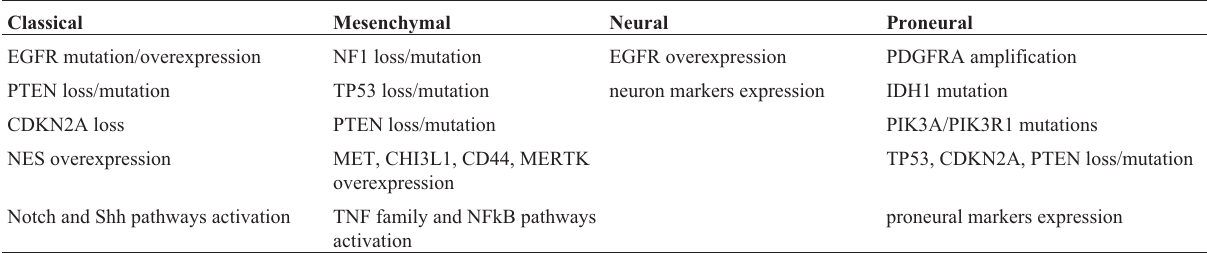
Table 2 - GBM subgroups and their main genetic changes. Classical Mesenchymal Neural Proneural EGFR mutation/overexpression NF1 loss/mutation EGFR overexpression PDGFRA amplification PTEN loss/mutation TP53 loss/mutation neuron markers expression IDH1 mutation CDKN2A loss PTEN loss/mutation NES overexpression MET, CHI3L1, CD44, MERTK overexpression Notch and Shh pathways activation TNF family and NFkB pathways